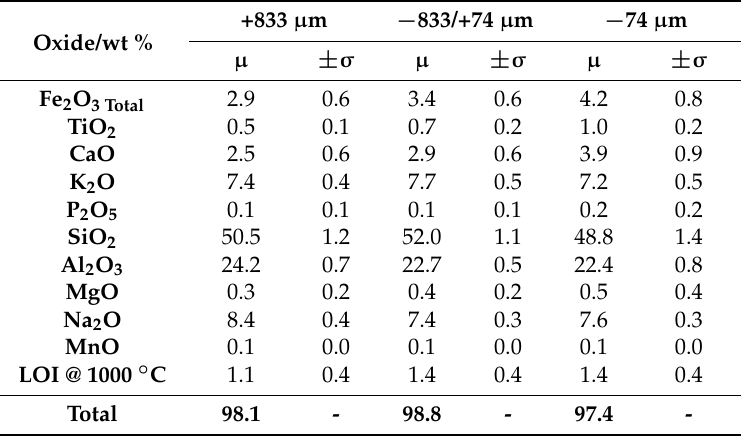
Table 3. Average and standard deviation of the chemical composition of all samples, for the +833, − 833/+74, and − 74 µ m size fractions. +833 µ m Oxide/wt %